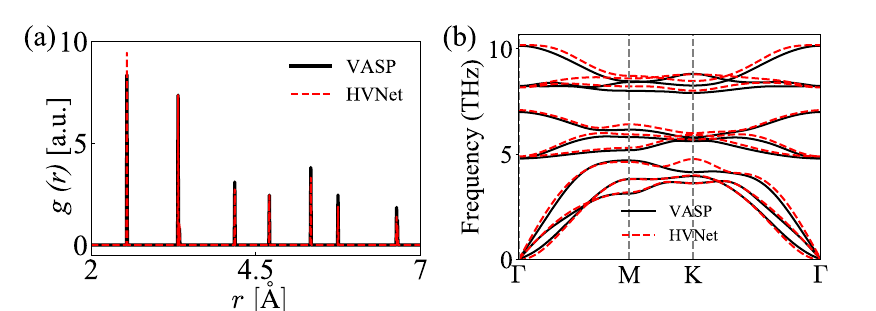
Fig. 4 Comparison of material properties. The radial distribution function g ( r ) ( a ) and phonon dispersions ( b ) for MoSe 2 . The data from DFT and HVNet are denoted by black solid and red dotted lines,